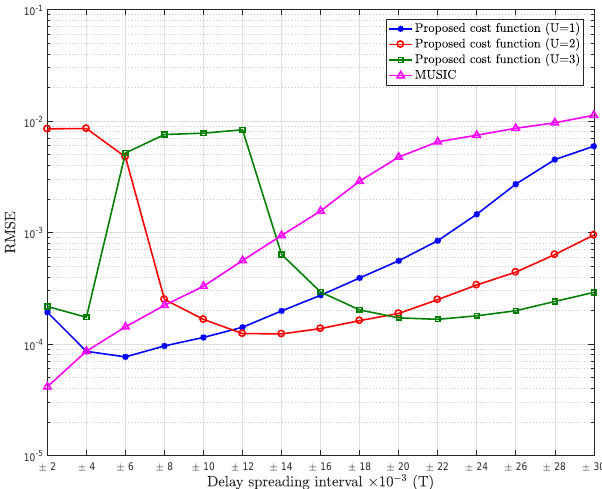
Figure 2. RMSE of mean delay estimation vs. delay spreading of the proposed cost function for U = 1 ( K − 2 L as noise subspace), U = 2 ( K − 3 L as noise subspace), U = 3 ( K − 4 L as noise subspace), and MUSIC; P l = 20, K = 64, signal-to-noise ratio (SNR) = 5